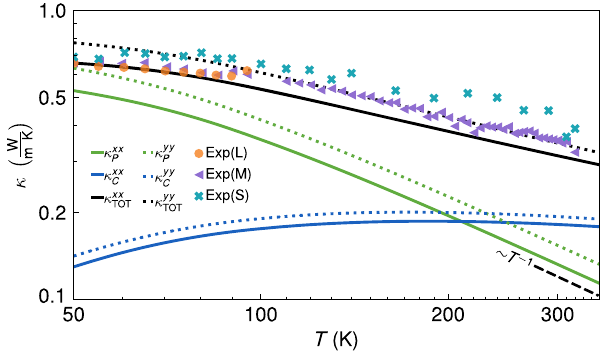
FIG. 6. Bulk thermal conductivity of CsPbBr 3 in the smooth phase convention. “ Exp(L), ” “ Exp(M), ” and “ Exp(S) ” refer to measurements [111] of κ xx in nanowires having, respectively, sections of 800 × 380 , 320 × 390 , and 300 × 160 nm 2 : their broad agreement supports the hypothesis of negligible finite-size boundary scattering [111]. Lines are theoretical predictions of the conductivity from Eq. (47) using the smooth phase convention, with solid lines referring to the tensor component κ xx (to be compared with experiments), and dotted lines referring to the component κ yy (this last is reported here for completeness and is practically indistinguishable from the not-reported component κ zz ). Green, Peierls ’ s LBTE conductivity ( κ P ), which displays the universal T − 1 asymptotics (dashed line) [19,21,23,115]. Blue, coherences ’ thermal conductivity ( κ C ). Black, total conductivity κ κ from Eq. (47): κ P þ C tot ¼